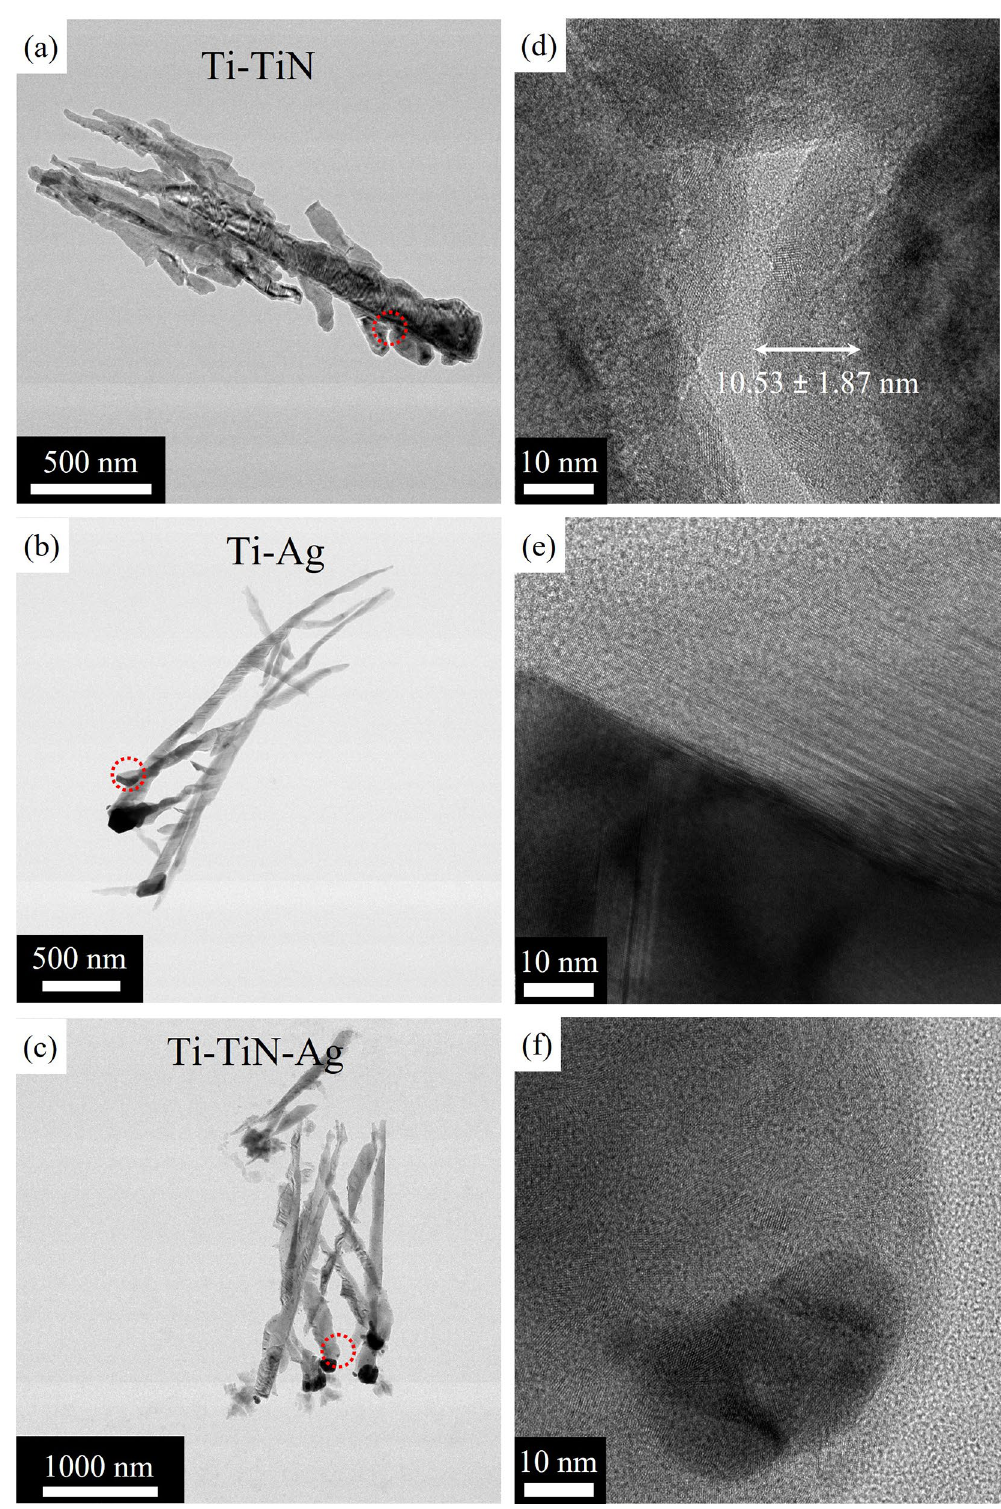
Figure 2. TEM image of branched Ti nanorod, ( a ) annealed for 4 h in N 2 , ( b ) capped with 100 nm of Ag on Ti, ( c ) capped with 100 nm of Ag on Ti annealed for 4 h in N 2 , and ( d – f ) is the magnified section of the circled spot of each